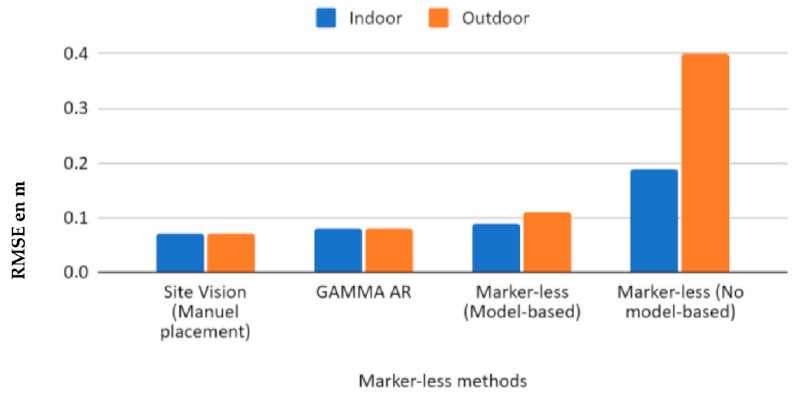
Figure 18. Placement accuracy of marker-less methods. Table 3. The stability of the AR placement methods.